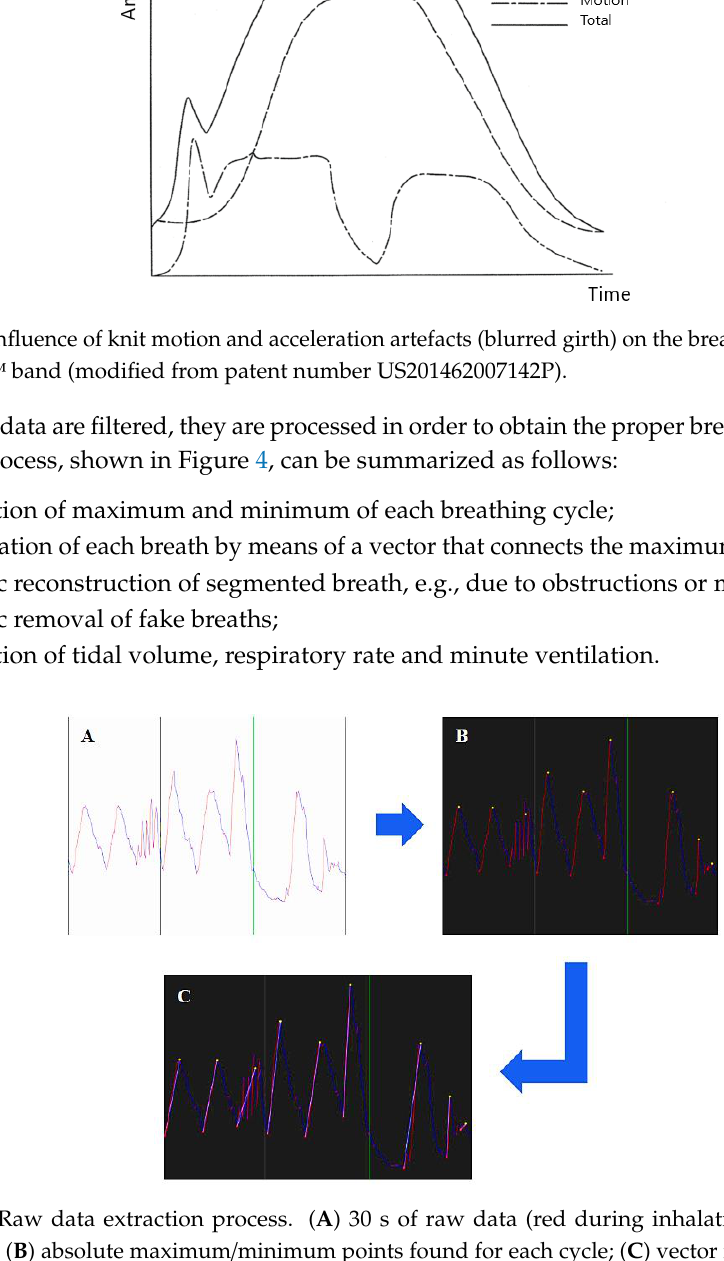
Figure 5. Box scheme of the raw signal processing and extraction process of the parameters of interest: amplitude (Amp), which represents Airgo™’s signal variation and models SensorMedics’ tidal volume; respiratory rate (RR); Airgo™’s minute ventilation (Amp×RR), which models SensorMedics’ minute ventilation; duty cycle, which is the ratio between inspiratory time and total breath period.